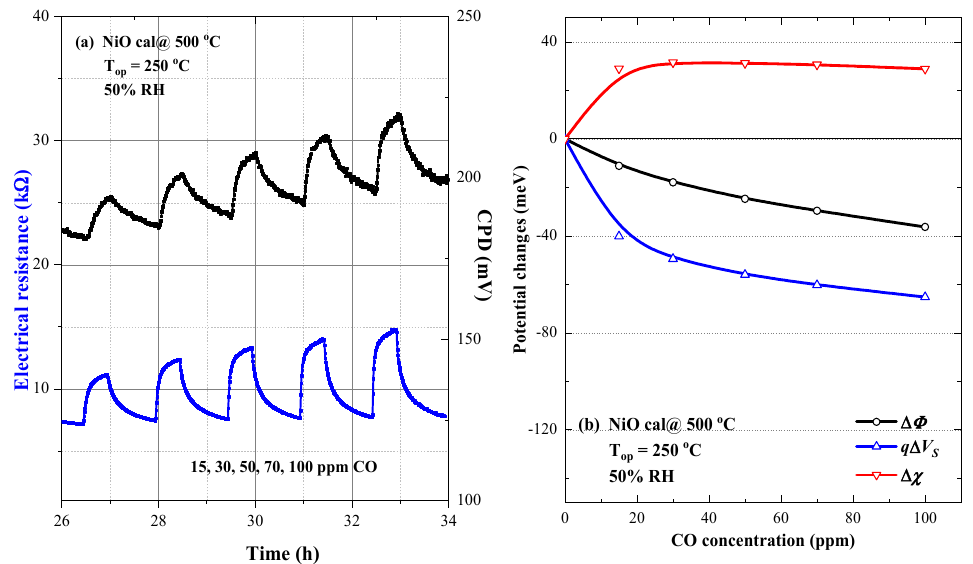
Figure 9. Electrical resistance and CPD changes with respect to the CO concentration ( a ); potential changes under CO exposure for NiO calcined at 500 °C ( b ).